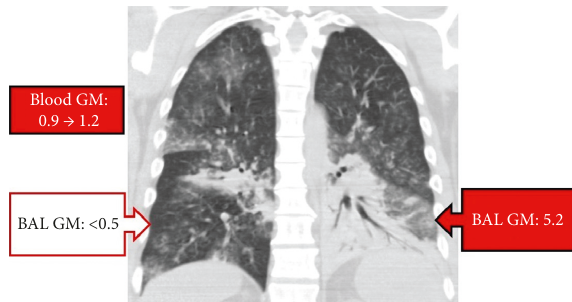
Figure 1: CT scan of the chest. Multifocal dense lung consolida- tions, most prominent in the left lower lobe, tree in bud opacities, and centrilobular nodules in the right lung; serum and left lower lobe: BAL galactomannan (GM) positive; right lower lobe: GM negative.